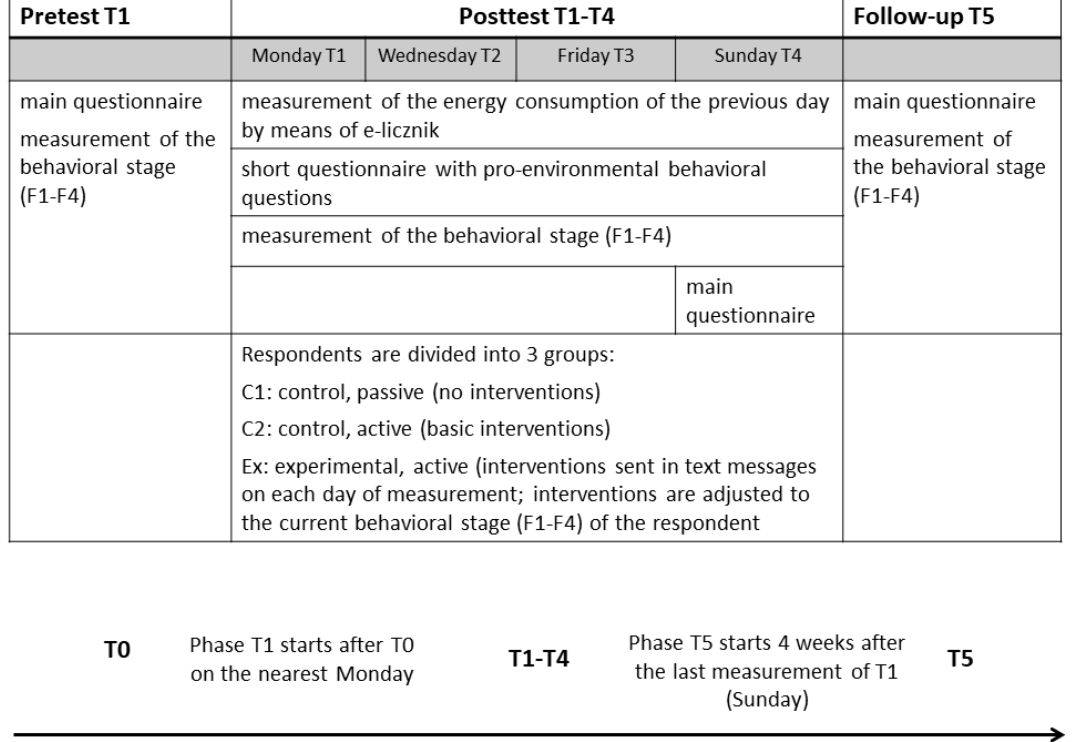
Figure 1. Survey framework with six measurement points: